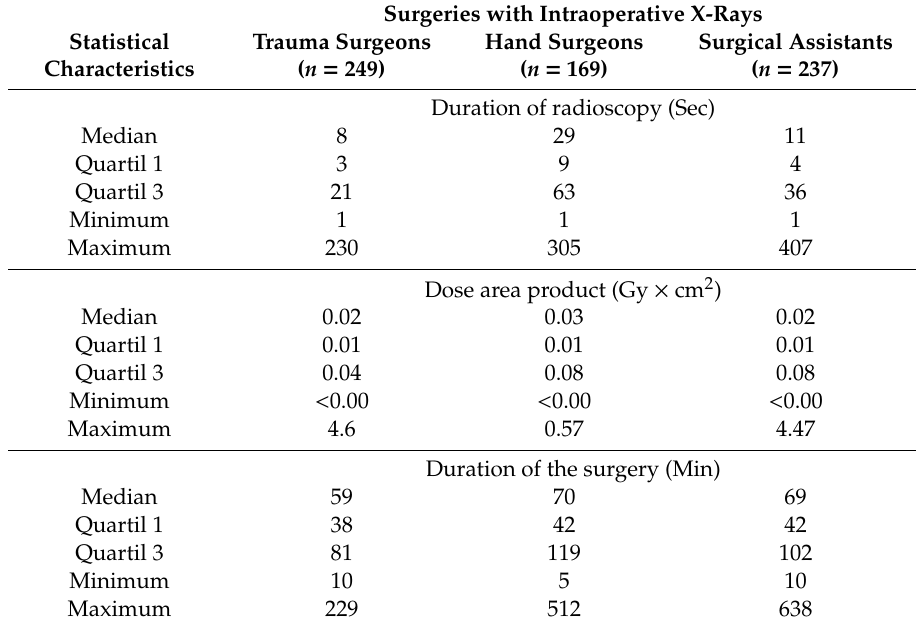
Table 1. Statistical characteristics of fluoroscopy time, dose area product and duration of